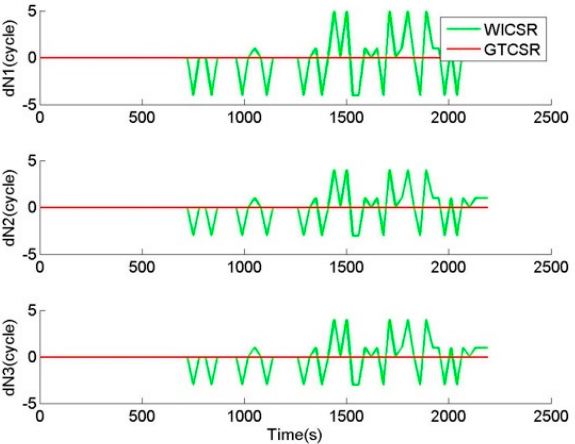
Figure 4. Original cycle slips of GTCSR and WICSR, where the pseudoranges and phases without cycle slips were collected at CUT0 station on GPS satellite 25 during the geomagnetic storm that started from UTC 2016/05/08 00:00:00.